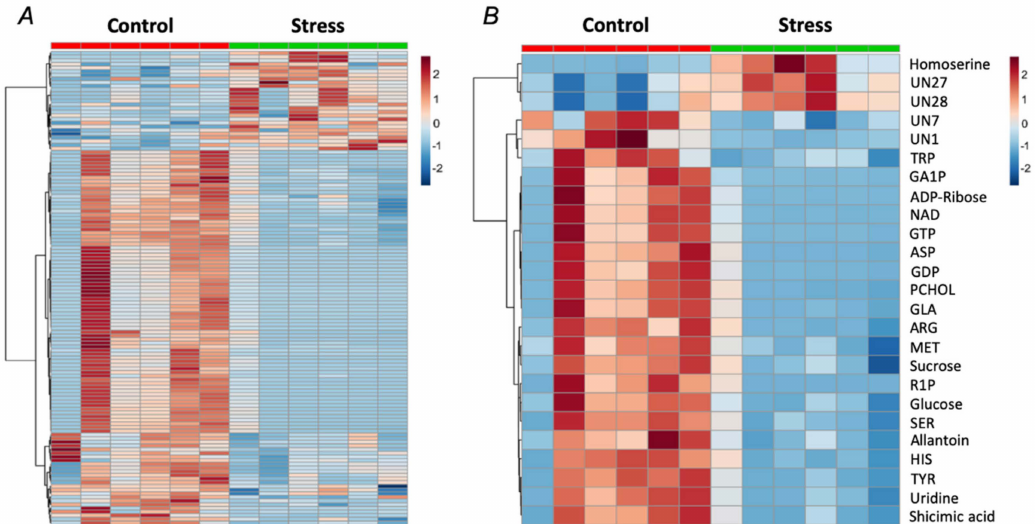
Figure 5. Heat map representing the features (both identified and unknown), di ff erentially (more than 1.5-fold, p < 0.05) abundant in the mature pea ( Pisum sativum L., cultivar SGE) seeds after a two-day exposure of the plants (at the seed maturation step) to the aqueous medium supplemented with 2.5% ( w / v ) PEG 8000 (stress, n = 6) in comparison to the seeds of the plants, treated with PEG-free medium (control, n = 6). The panel A represents the overall view of 129 features (listed in Supplementary Materials 2, Table S2-1), whereas the panel B represents the 20 most confident features (listed in the order of decreasing confidence, i.e., increasing p value), based on ANOVA. The non-identified features are labeled as unknowns (UN). UN 27, m / z 188.1648; UN 28, m / z 132.1023; UN 7, m / z 67.0297; UN 1, m / z 374; TRP, tryptophan; GA1P, glucosamine-1-phosphate; ADP-ribose, adenosine diphosphate ribose; NAD, nicotinamide adenine dinucleotide; GTP, guanosine-5 (cid:48) -triphosphate; ASP, aspartic acid; GDP, guanosine-5 (cid:48) -diphosphate; PCHOL, phosphocholine; GLA, glutamic acid; ARG, arginine; MET, methionine; R1P, ribose-1-phosphate; SER, serine; HIS, histidine; TYR, tyrosine. Heatmap